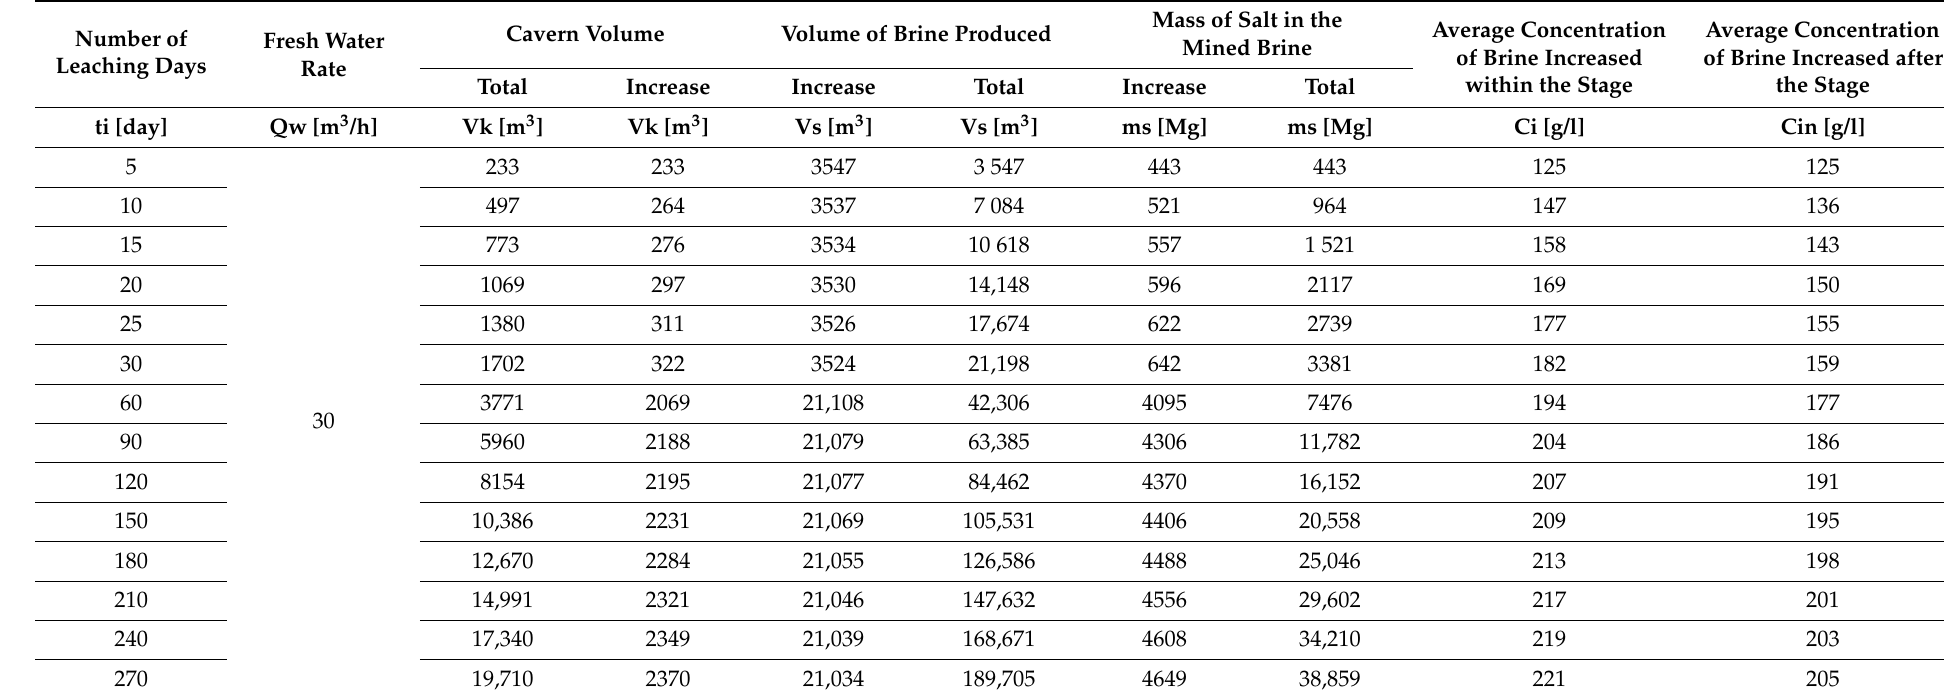
Table 7. Development of the sump leaching process after cutting 2 niches (R1 = R2 = 5 m)—Stage I/Scenario 2 (S I/S